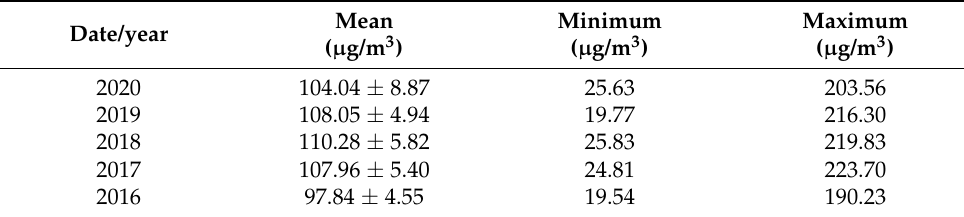
Table 1. Statistics of O 3 -8h data in the NCP from 2016 to 2020. (Mean ±